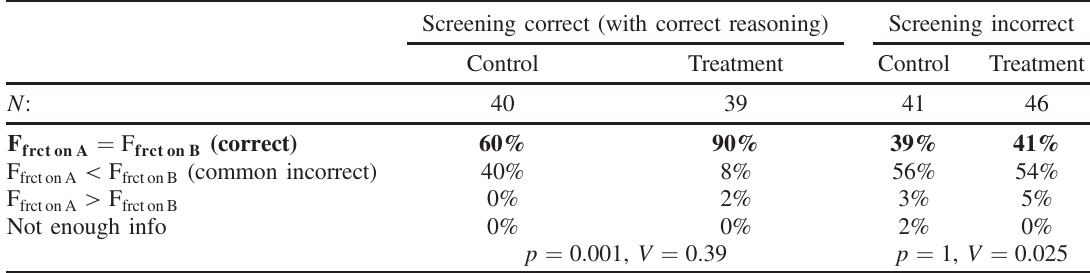
TABLE IX. Response data for the two-box friction task separated into control (no AIE) and treatment (with AIE) groups while controlling for performance on the screening question (experiment 2B). The task itself is shown in Fig. 2(b). The correct answer choice is in boldface for